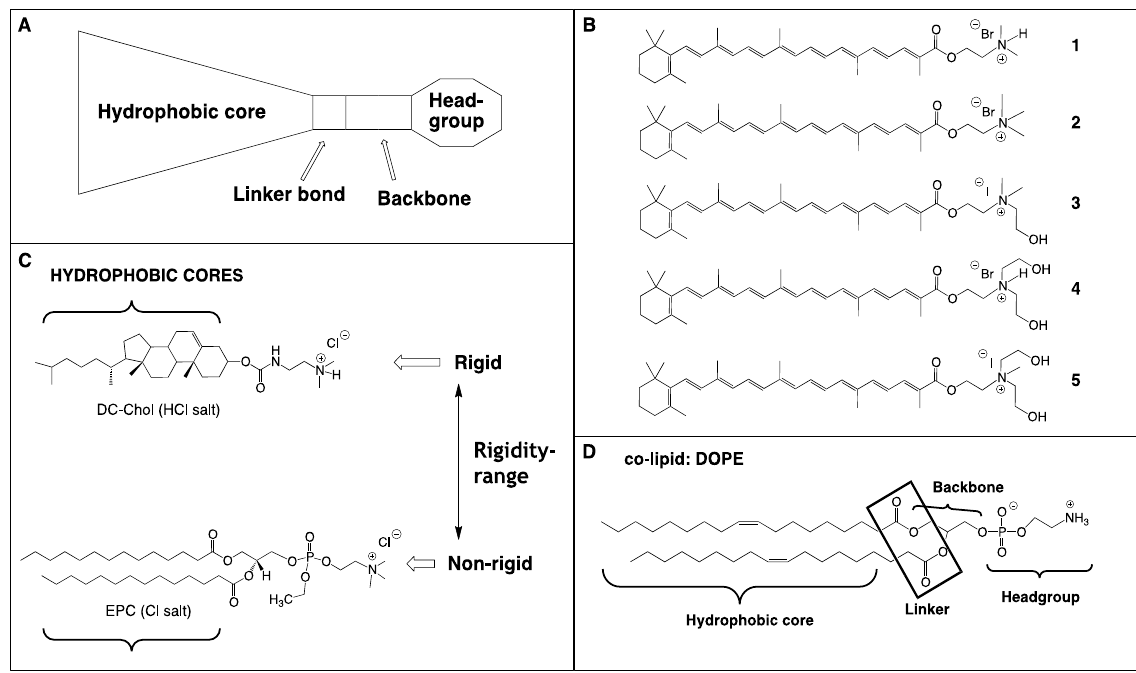
Figure 2. The basic structural of components used in this study. A : General lipid structure including a hydrophobic domain, linker bond, backbone and a polar headgroup; B : Structures of single-chain rigid cationic carotenoid lipids, 1 – 5 ; C : The rigidity range associated with the hydrophobic domain of common cationic lipids, DC-Chol and EPC used as positive controls; D : Structure of co-lipid